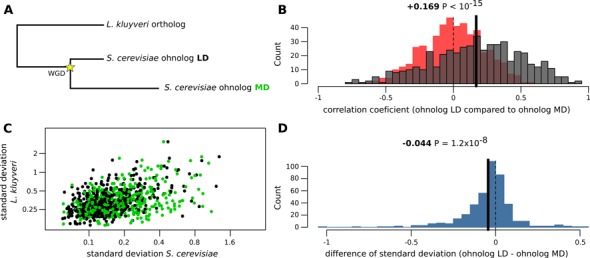
Comparison of expression variation of the 534 ohnolog pairs conserved after the WGD in S. cerevisiae, with the corresponding unique ortholog in the protoploid species L. kluyveri. (A) Scheme depicting the evolution of genes after the WGD, LD: less divergent, MD: more divergent. (B) Repartition of the degree of co-expression of the two ohnologs in S. cerevisiae. (C) Comparison of expression variation of the ohnolog pairs with the L. kluyveri orthologs. Black: less divergent ohnologs, green: more divergent ohnologs. (D) Repartition of the difference in variability between the two ohnologs.